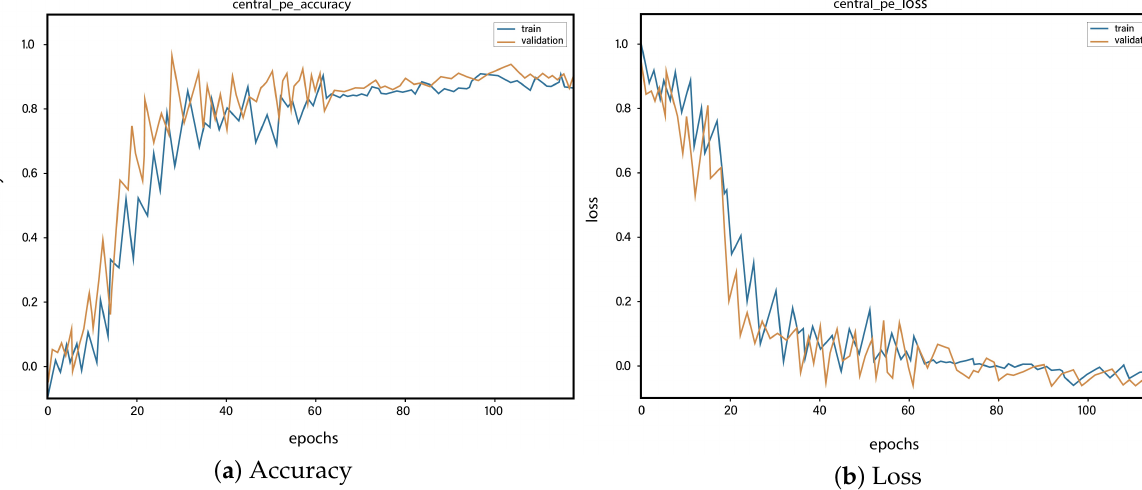
Figure 10. Training vs. validation accuracy and loss for the class: Central